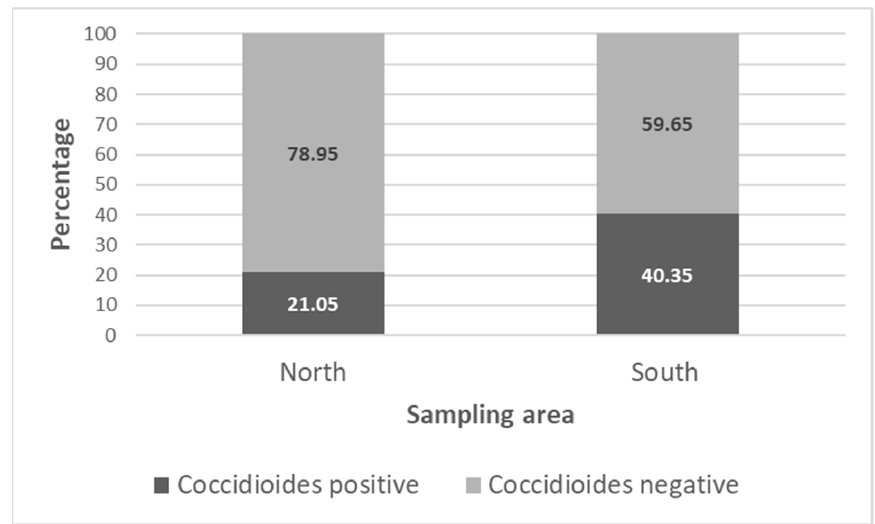
Figure 4. Percentage of positive and negative soil samples in the northern and southern sampling area for all soil samples collected in 2018, 2019, and 2021 (n = 114).